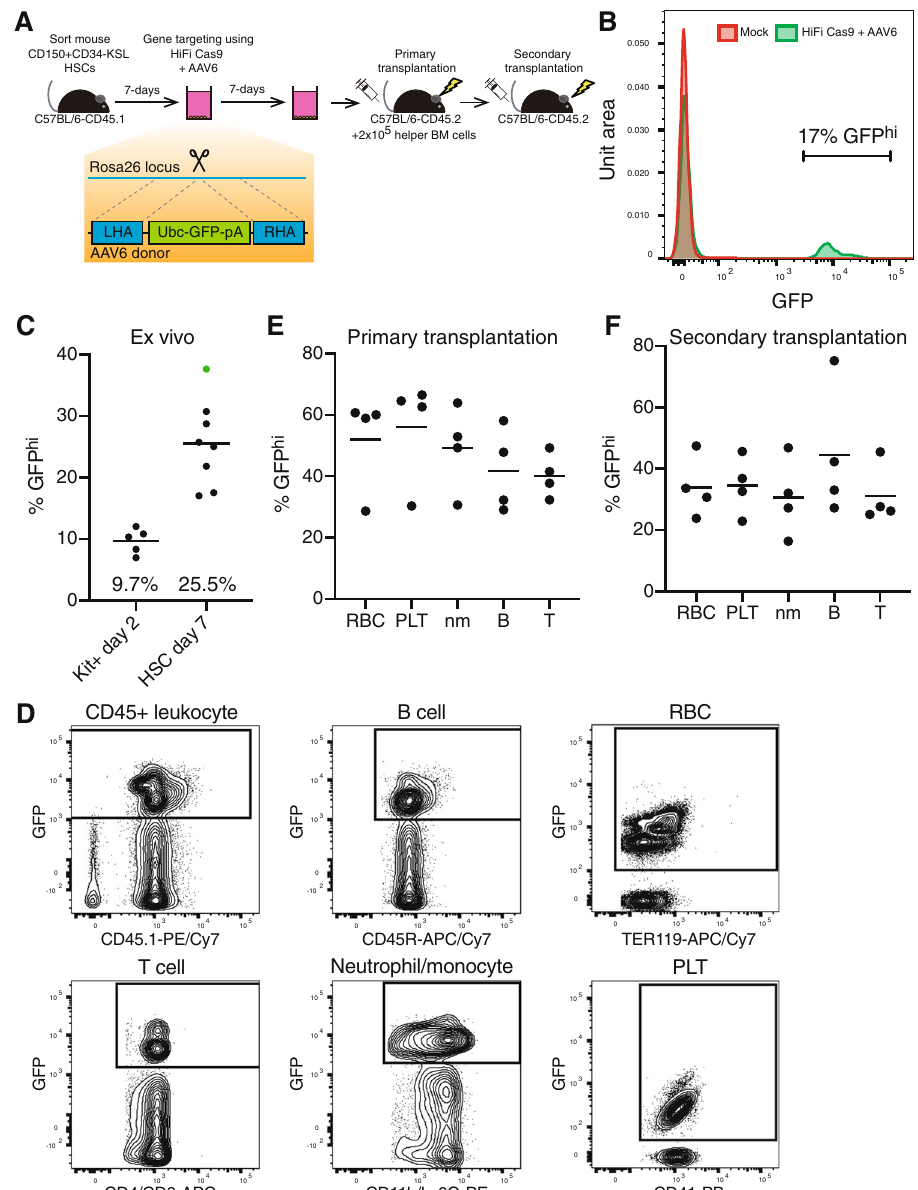
Fig. 1 Cas9-AAV6 gene editing of functional multipotent LT-HSCs. A Experimental schematic for introducing a GFP expression cassette into the Rosa26 locus of mouse hematopoietic stem and progenitor cells (HSPCs) via Cas9-AAV6 gene targeting and functional assessment by transplantation assays. B Representative fl ow cytometry histogram of GFP expression from day-14 HSPC cultures. C Mean frequency of GFP hi cells from Rosa26 gene editing schematized in ( A ) when performed on day-2 cKit-enriched bone marrow (BM) cells or day-7 HSC-derived cultures, measured by fl ow cytometry ( n = 5 and n = 8 independent cell cultures, respectively). HSPC culture highlighted in green used for transplant studies described in ( E ). D Representative fl ow cytometric plots for GFP expression within peripheral blood (PB) CD45 + leukocyte, CD45R + B cell, and CD4/CD8 + T cell, CD11b/Ly-6G + myeloid neutrophils/monocyte (nm), Ter119 + red blood cell (RBC) and CD41 + platelet (PLT) populations in transplant recipients described in ( A ). E Mean frequency of GFP hi cells in PB lineages of primary recipients at 20-weeks post-transplantation, measured by fl ow cytometry. Day-14 cultures (derived from 200 HSCs; ~2 × 10 5 cultured cells) transplanted alongside 2 × 10 5 helper whole bone marrow cells (WBMCs) per recipient ( n = 5 mice). F Mean frequency of GFP hi cells in PB lineages of secondary recipients at 12-weeks post-transplantation, measured by fl ow cytometry. 1 × 10 6 WBMCs collected from all primary recipient mice ( E ) were transplanted per secondary recipient ( n = 4 mice). Source data are available in the Source data fi